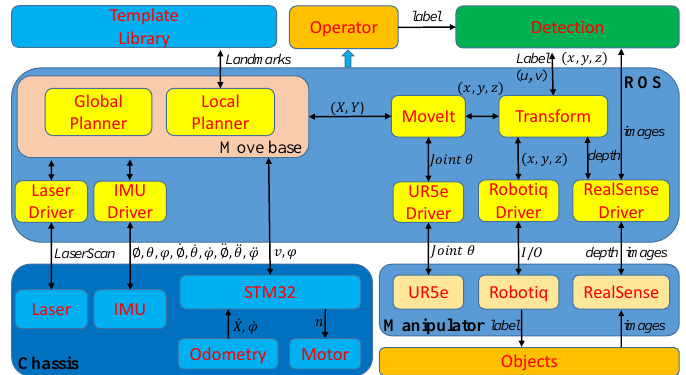
Figure 7. ROS-Based Control Framework.